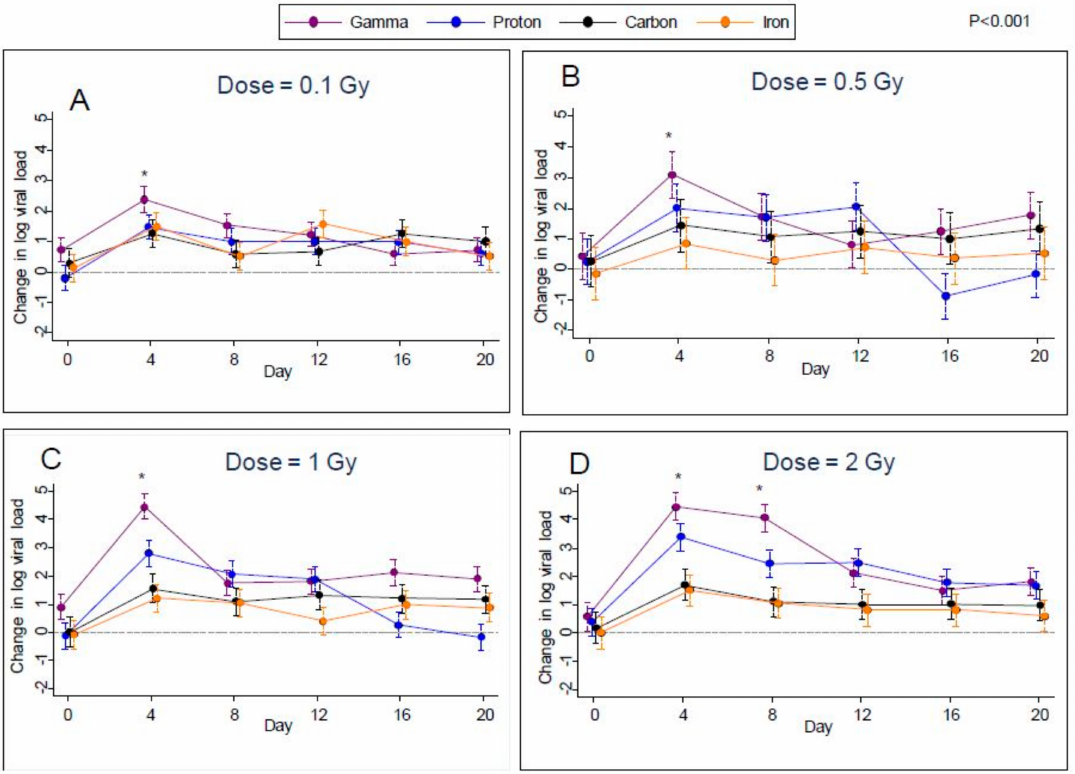
Figure 3. Change in viral loads (EBV DNA) compared to control following gamma, proton, carbon, and iron radiation at different dosages, ( A ); 0.1, ( B ); 0.5, ( C ), 1.0 and ( D ), 2.0 Gy treatments with 95% confidence limits